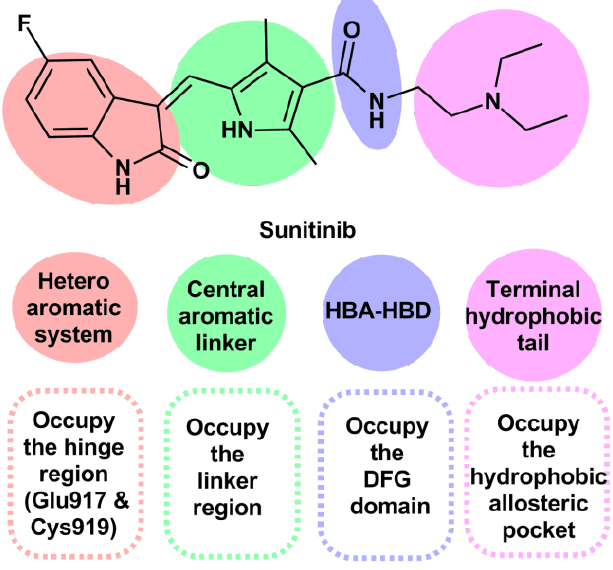
Figure 1. VEGFR-2 inhibitors approved by the FDA.